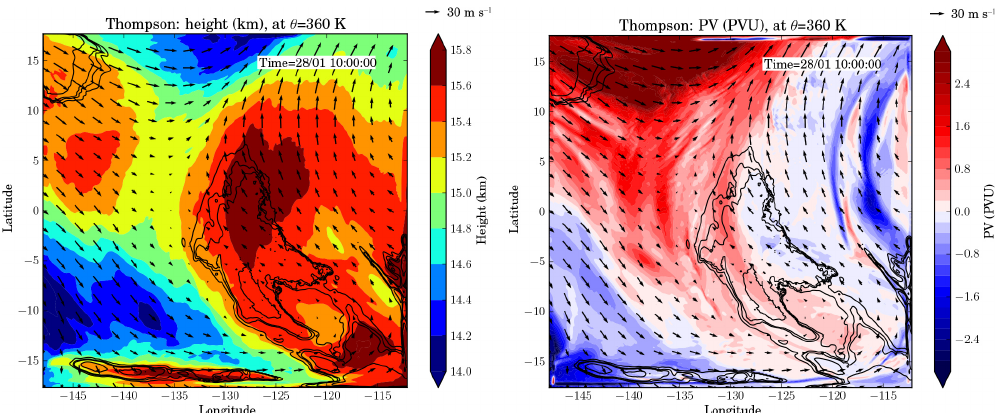
Figure 3. Fields from the reference simulation with Thompson microphysics, on the 360 K isentrope, showing (left) geopotential height (km, colours) and ice water content (1 × 10 − 8 , 5 × 10 − 8 , 1 × 10 − 8 and 5 × 10 − 8 kgkg − 1 , black contours) and (right) potential vorticity (PVU, colours) and ice water content. Wind vectors are also displayed.